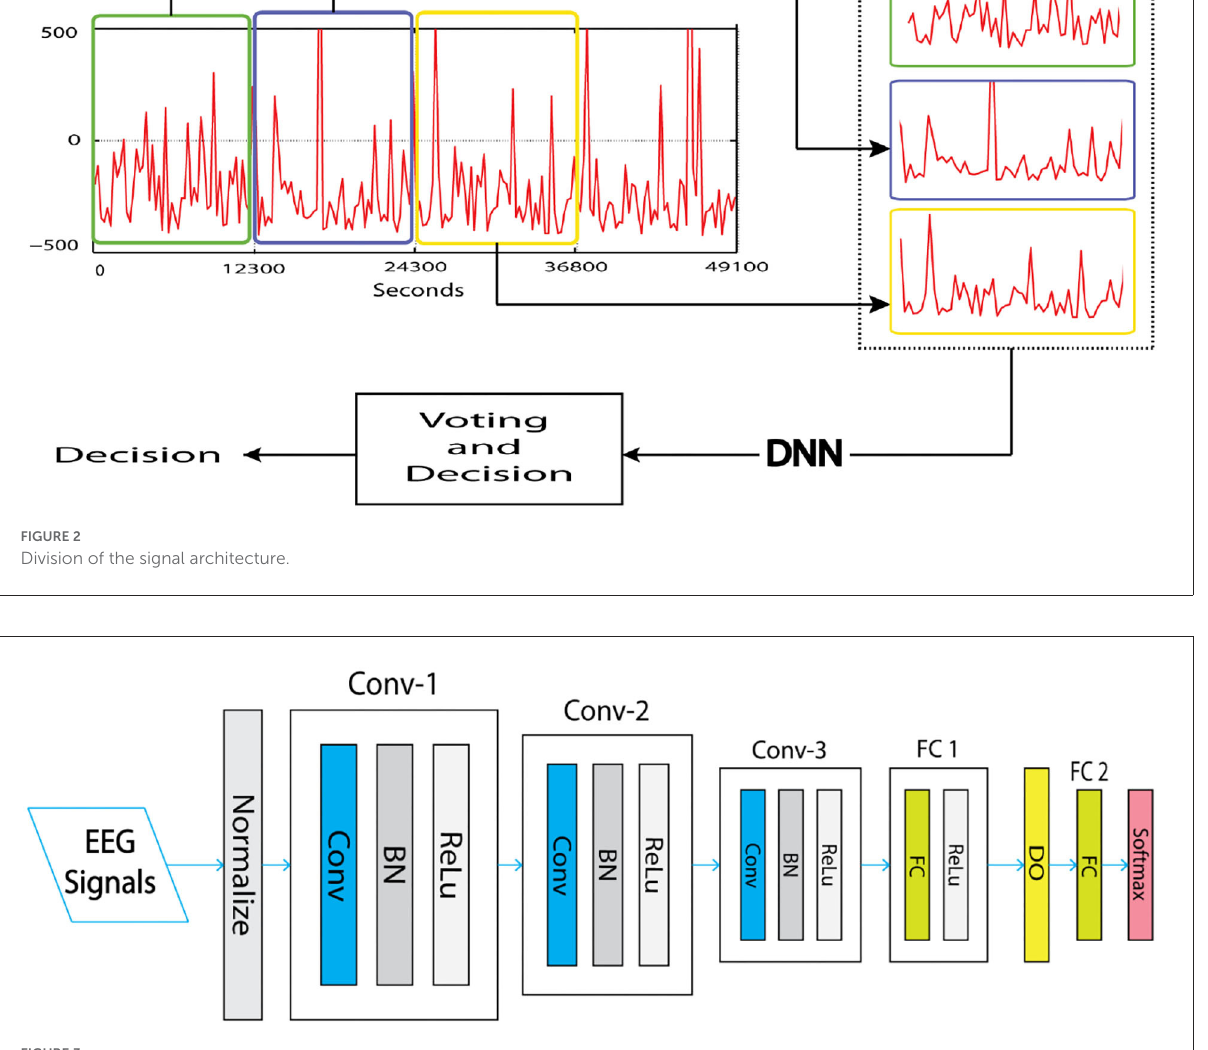
FIGURE3 1 P convolutional neural network (CNN)